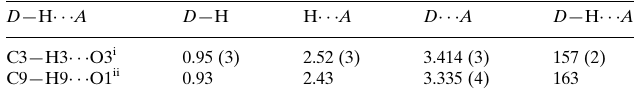
Hydrogen-bond geometry (A˚ , (cid:2)